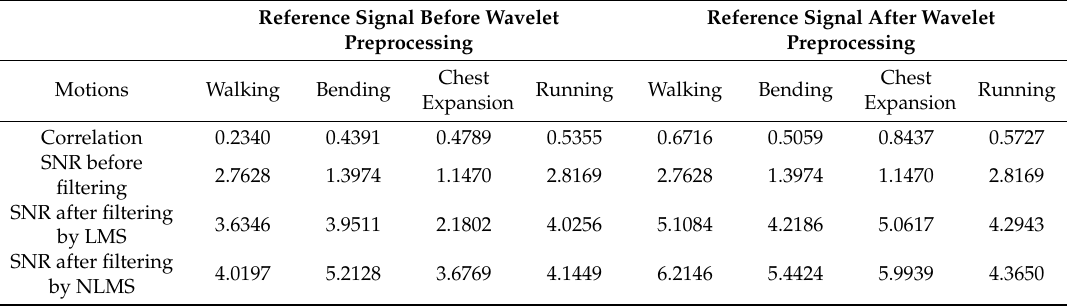
Figure 6. ( a ) Correlation coefficients between reference signal and main input ECG signal before and after wavelet transform preprocessing and ( b ) SNR before and after filtering. Table 1. SNR before and after filtering based on the LMS and NLMS algorithms for different motion signal inputs.